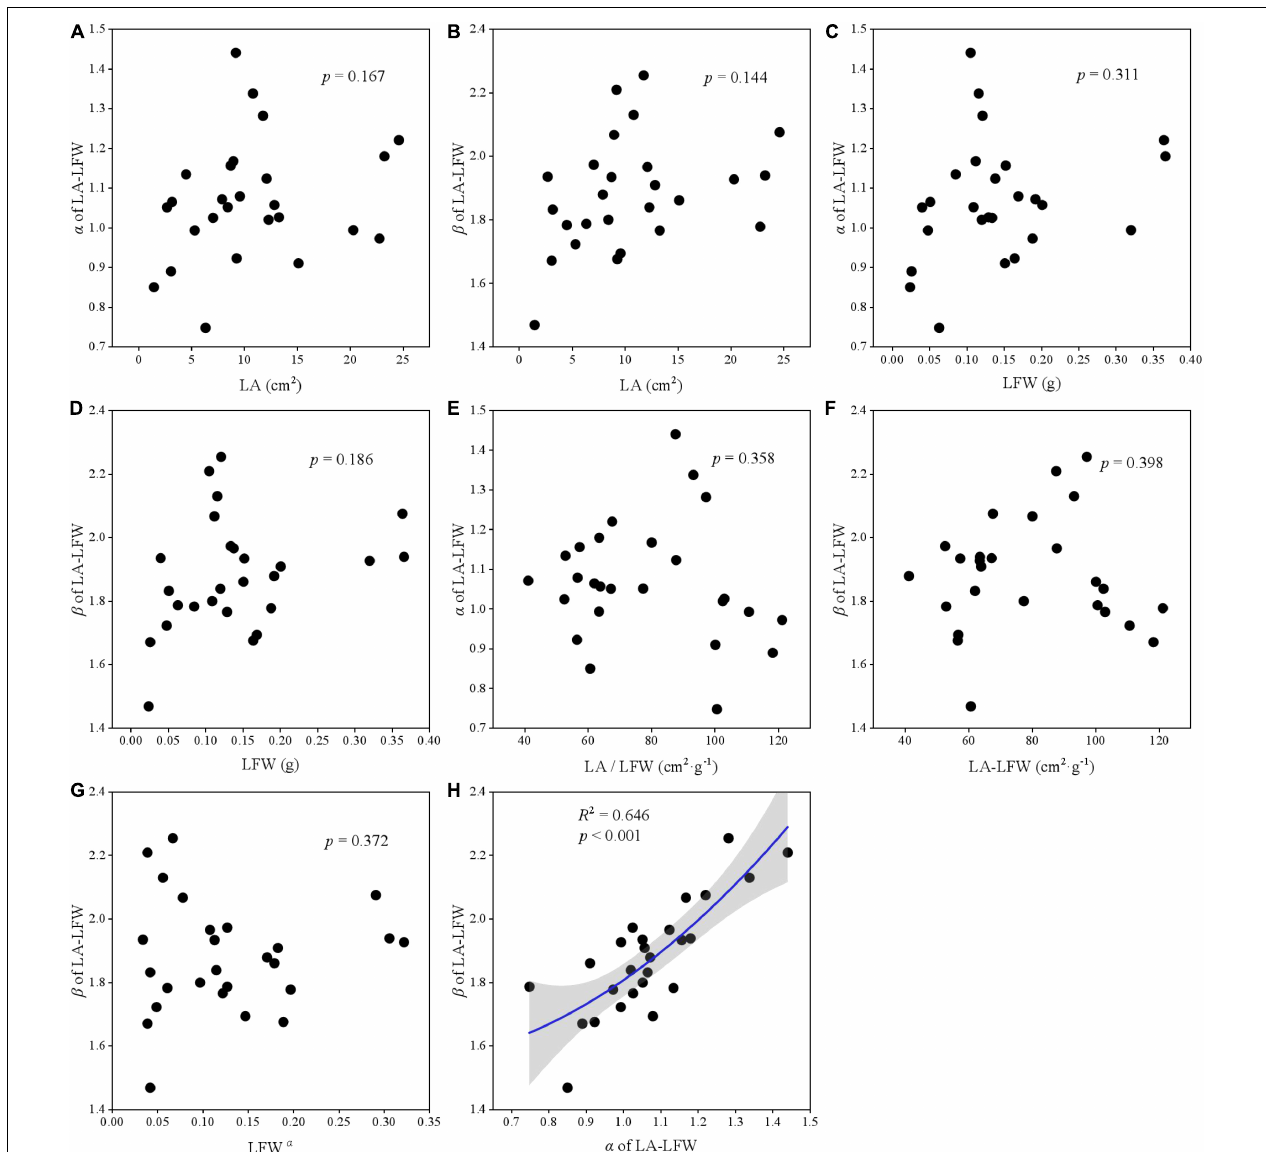
FIGURE 6 | The correlation relationship of parameters of LA and LFW. (A) The relationship between α and LA; (B) the relationship between β and LA; (C) the relationship between α and LFW; (D) the relationship between β and LFW; (E) the relationship between α and LA/LFW; (F) the relationship between β and LA/LFW; (G) the relationship between β and LFW α ; and (H) the relationship between β and α